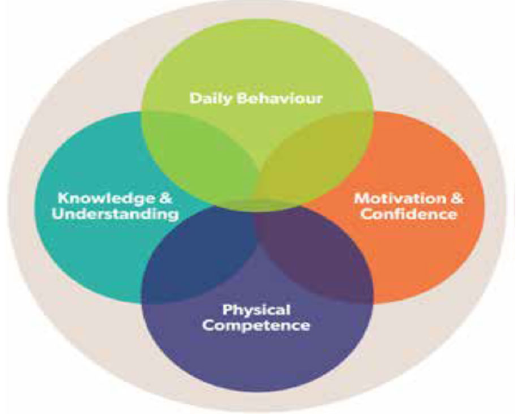
Figure 1. Core domains of physical literacy adapted from CAPL ‐ 2 manual HALO (2017) [31]. The total PL scores for each child were converted to a score out of 100 by